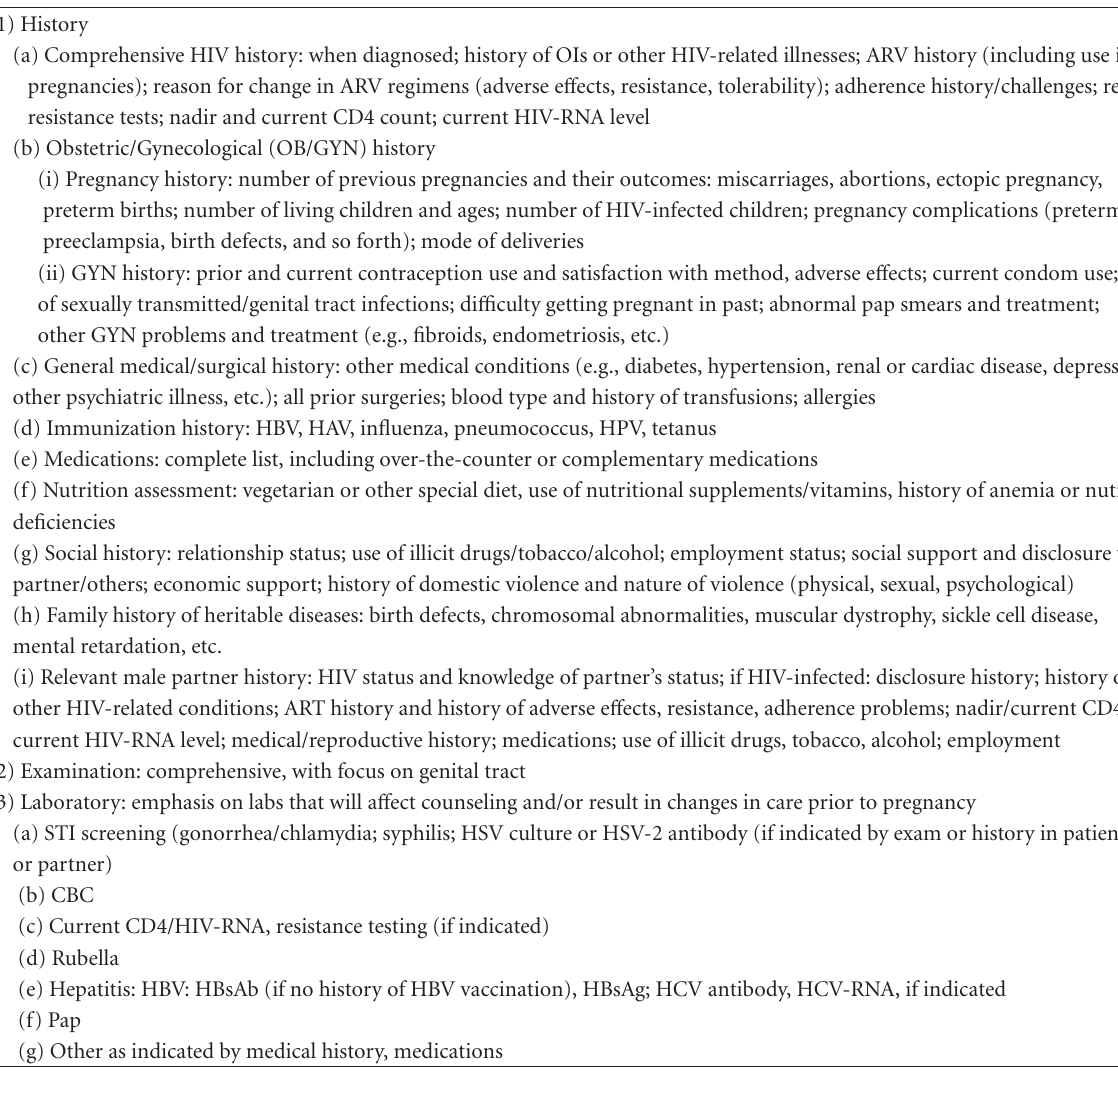
Table 4: Components of the preconception evaluation for women living with